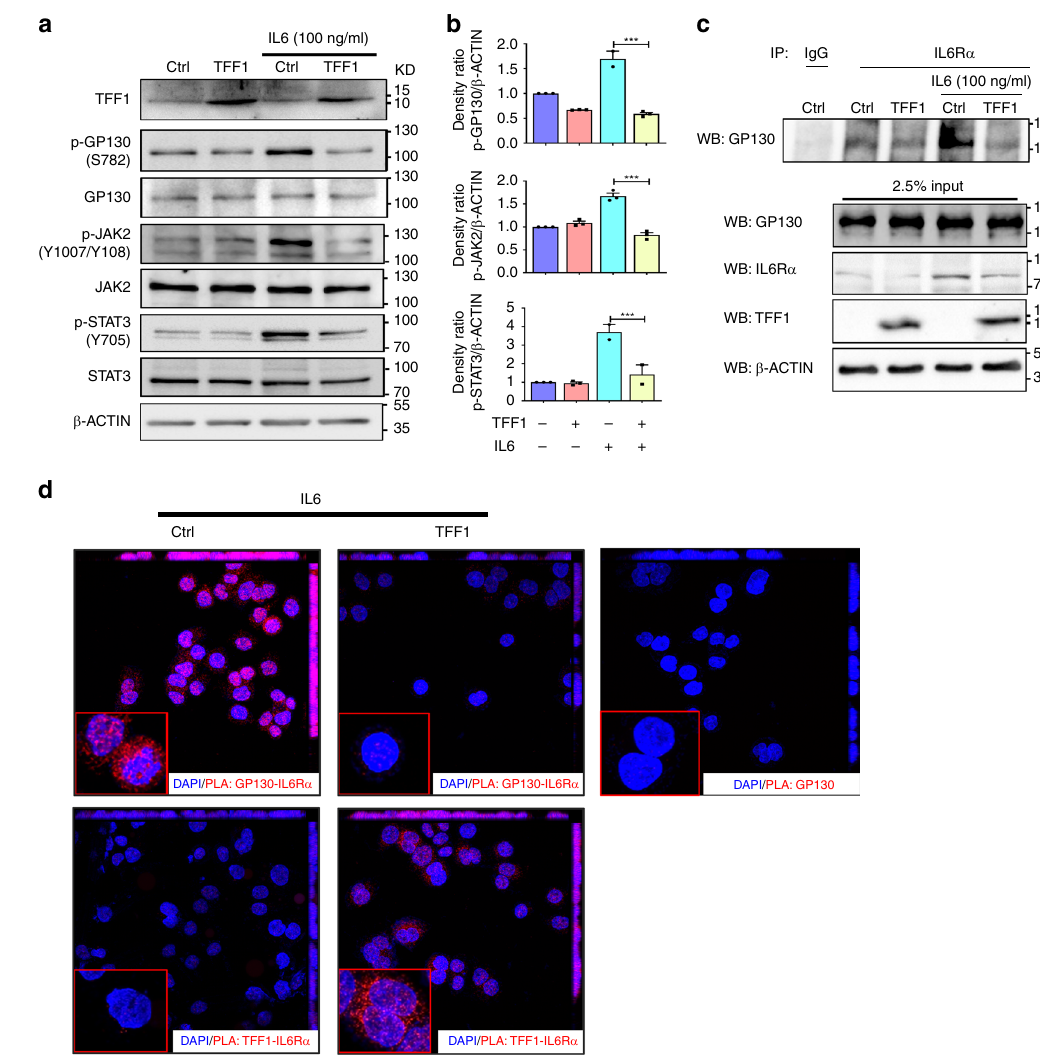
Fig. 7 TFF1 negatively regulates IL6-induced STAT3 activation through GP130-IL6R α axis. a Western blot analysis using AGS cell lines infected with control or TFF1 adenovirus. After stimulation with IL6 (100 ng mL − 1 ) for 30 min, TFF1 expressing cells showed a signi fi cant decrease of p-STAT3 (Y705), p-GP130 (S782), and p-JAK2 (Y1007/Y1008) protein levels as compared to control cells. b The relative intensity ratio of p-JAK2/ β -Actin, p-GP130/ β -Actin, and